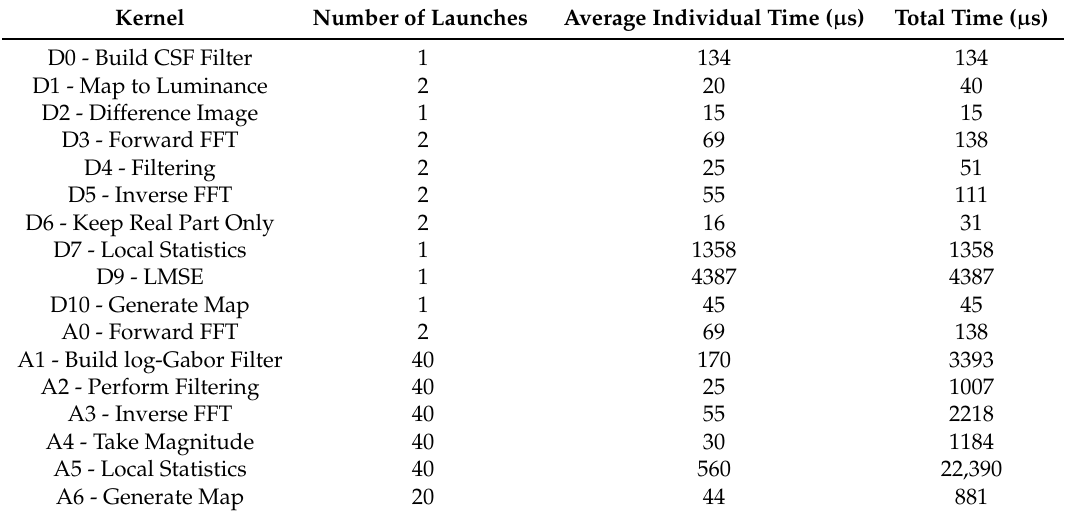
Table 4. Runtimes of the individual kernels.